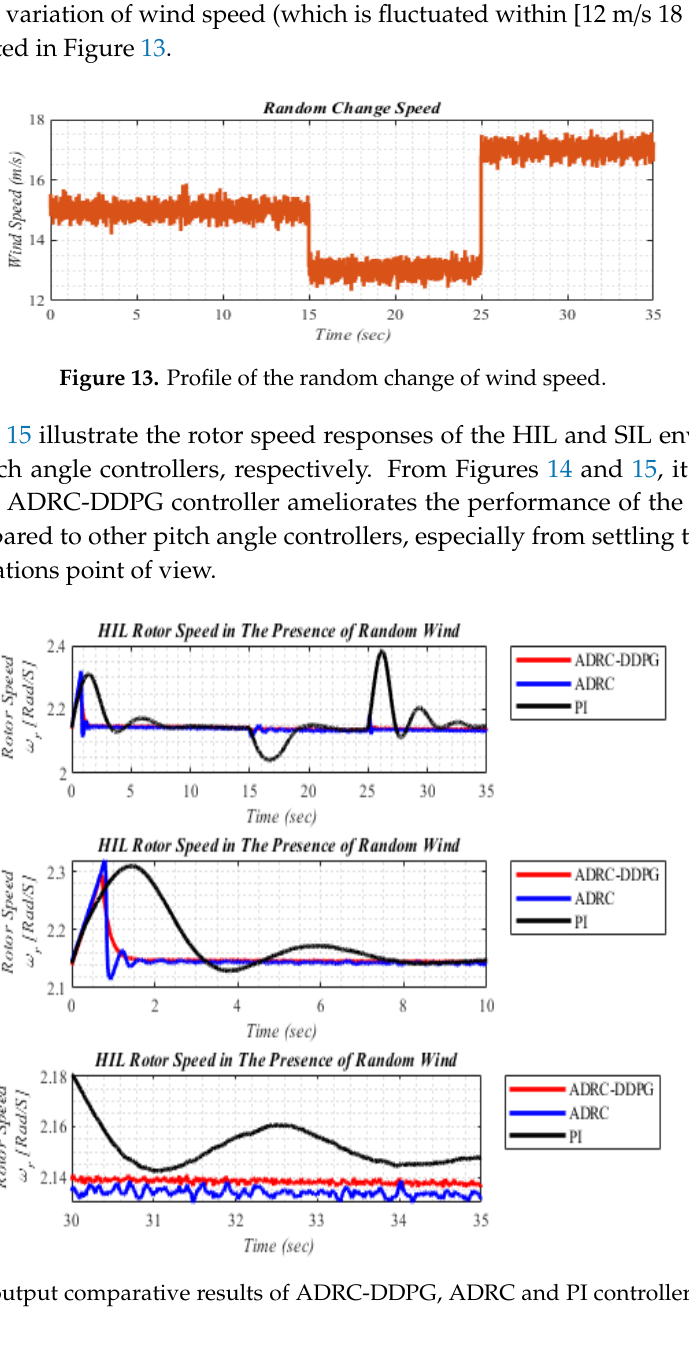
Figure 15. SIL output comparative results of ADRC-DDPG, ADRC and PI controllers according to scenario II. 5.3. The Parametric Uncertainty in the Turbine Model